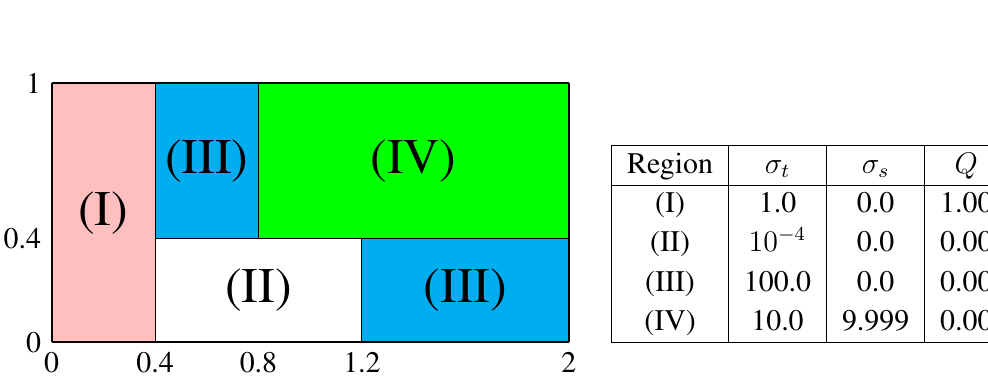
Figure 3: Configuration of the 2D shielding problem where (X) denotes the region